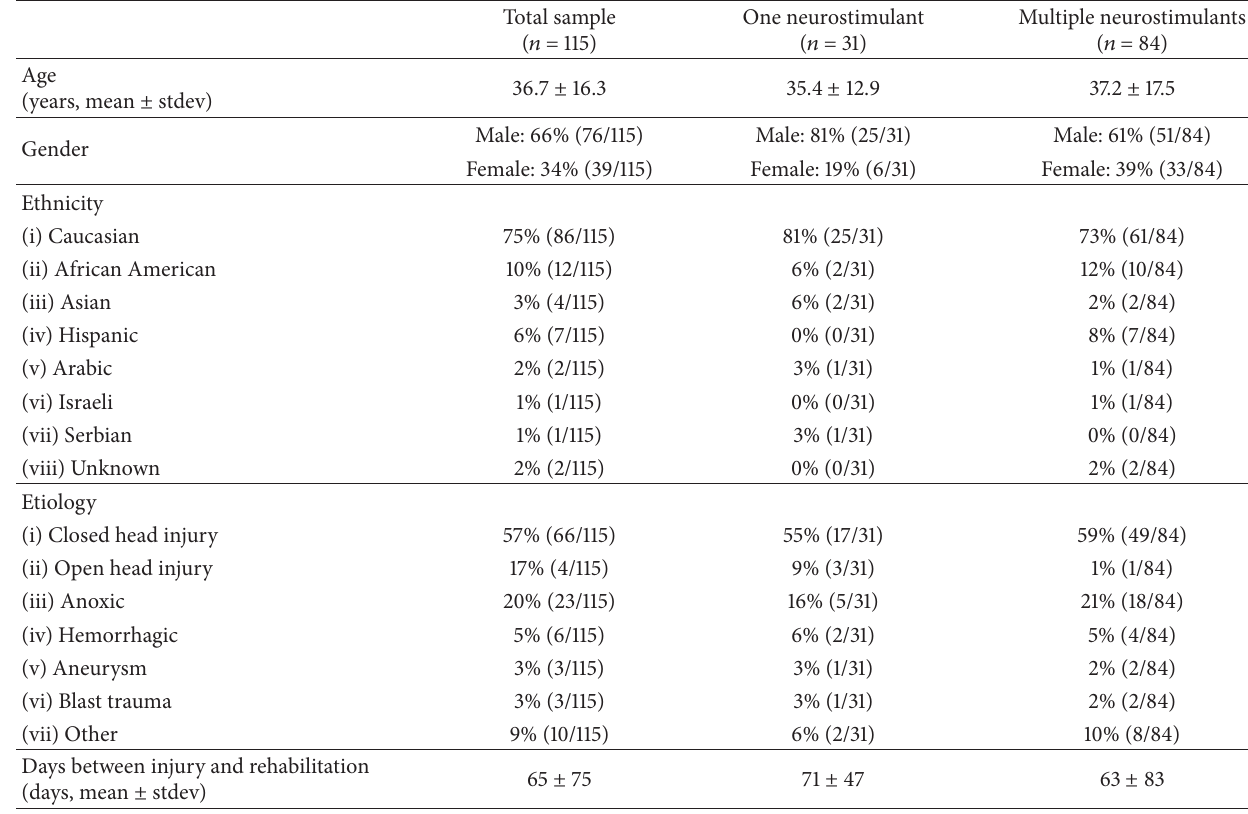
Table 1: Summary of sample characteristics.